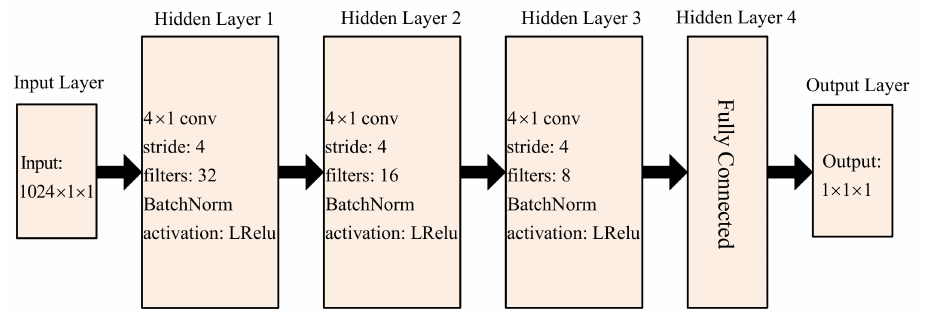
Figure 7. Detailed structure diagram of the discriminative